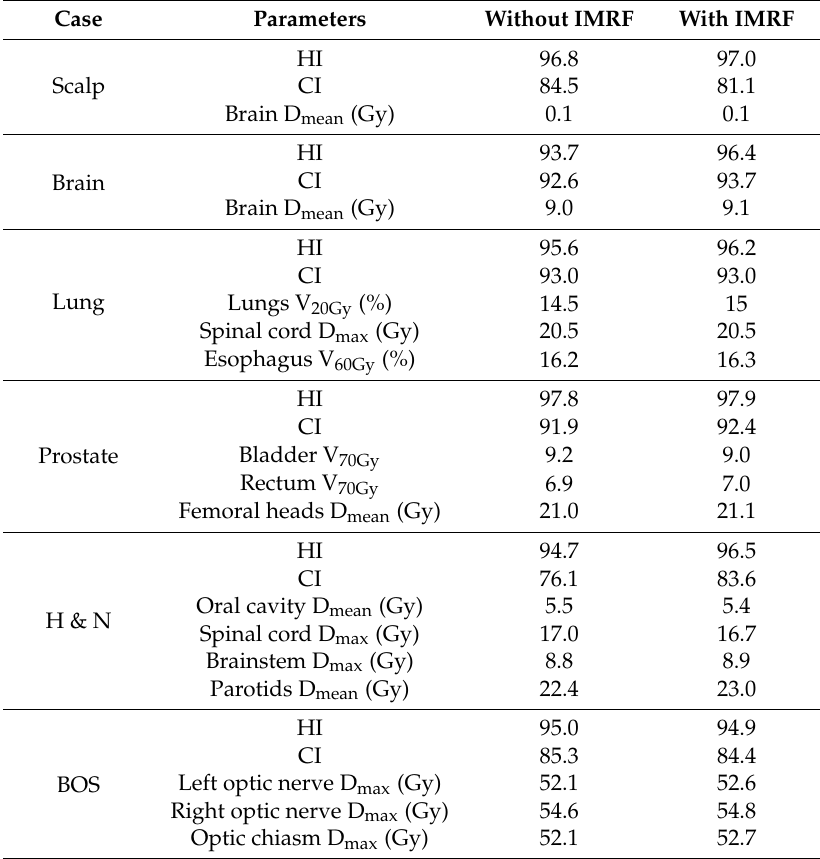
Table 4. Dosimetric comparison of plans without and with